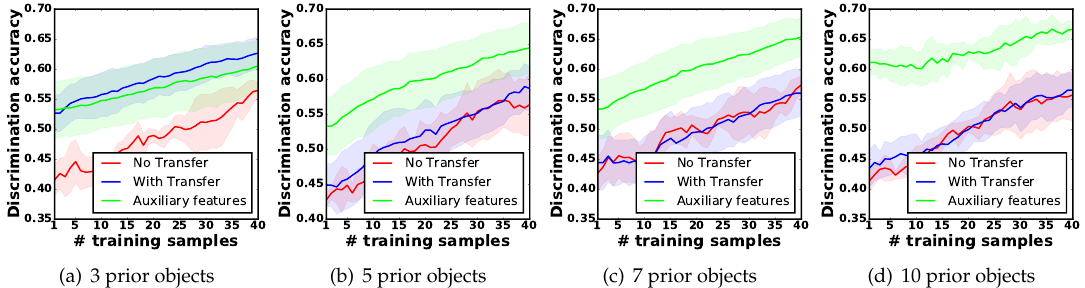
Figure 9. Increasing the number of prior objects from 3, 5, 7 to 10, and comparing the performance of different learning methods. Red: baseline method; Blue: the proposed active prior tactile knowledge transfer method (APTKT) without auxiliary features; Green: APTKT with auxiliary